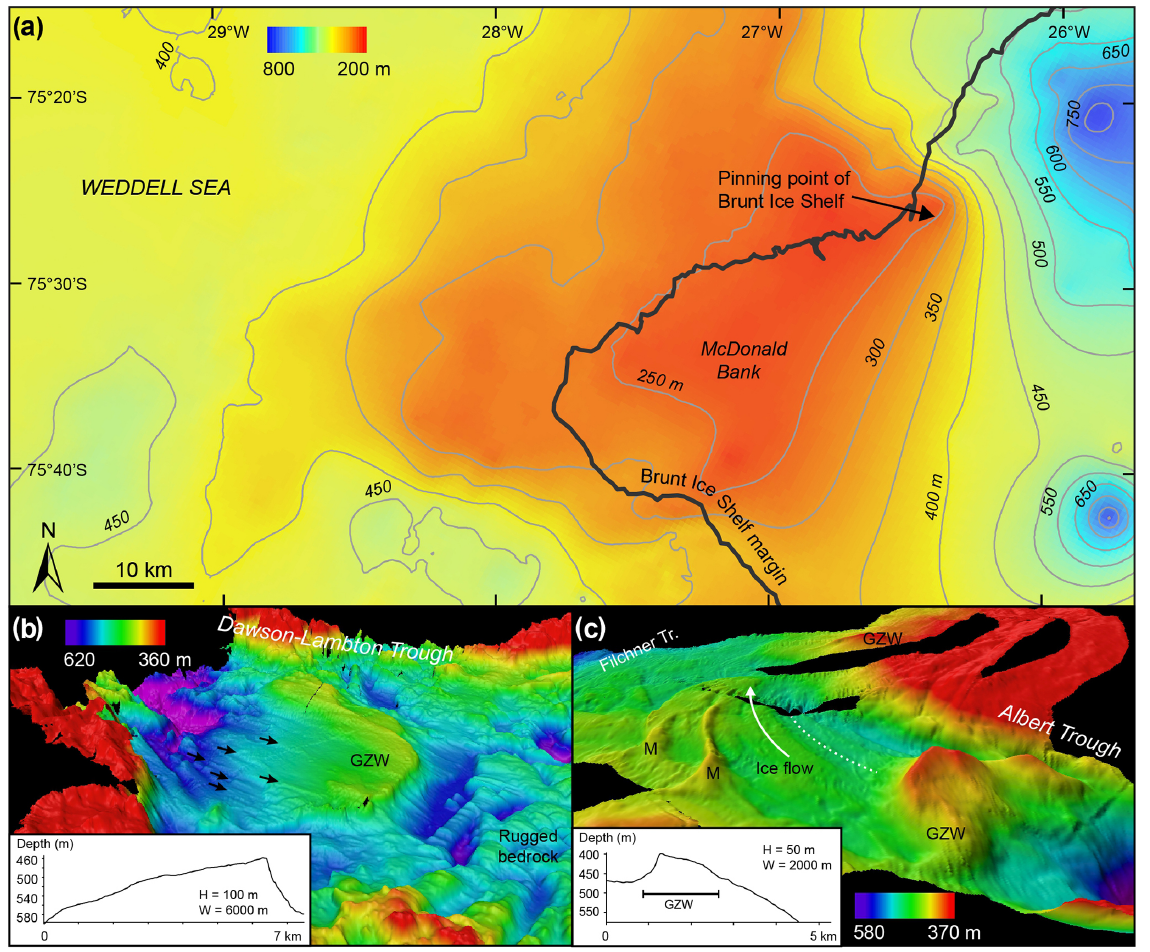
Figure 4. (a) Bathymetry of the McDonald Bank, a topographic high that rises to ∼ 220m (water depth) under the Brunt Ice Shelf between the Brunt Basin and the Filchner Trough in the eastern Weddell Sea. The south-east part of the McDonald Bank consists of a ca. 75m high ridge of sediments with internal truncated reflections (seismic profile 5; Elverhøi and Maisey, 1983). At its highest point, this ridge makes contact with the Brunt Ice Shelf forming the McDonald Ice Rumples. Three-dimensional images of grounding-zone wedges (GZWs) in (b) Dawson-Lambton Trough and (c) Albert Trough. Black arrows in (b) point to glacial lineations; insets show cross profiles of the